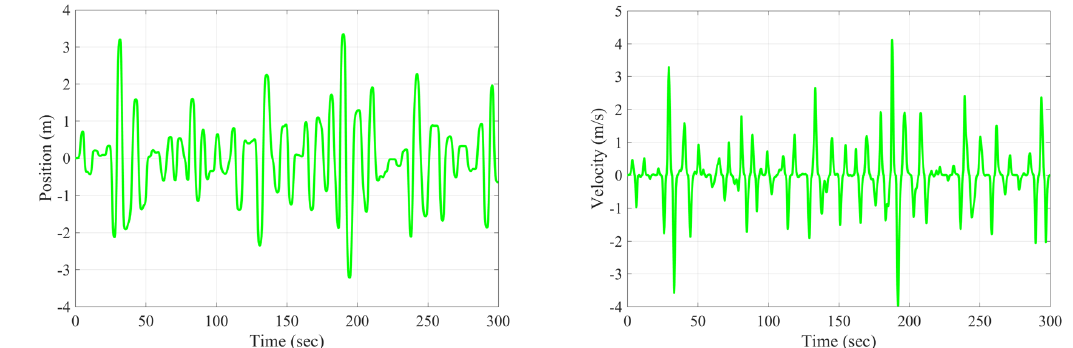
Figure 23. SS4 position ( left ) and velocity ( right ),